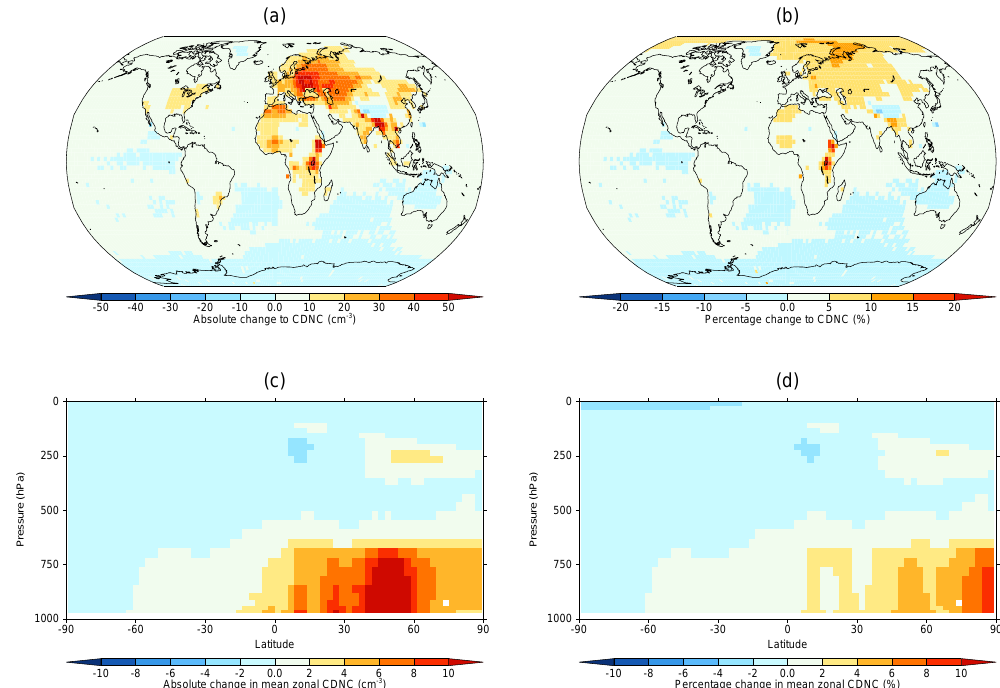
Figure 13. Simulated absolute and percentage change in annual mean at low cloud height (850–900hPa) (a–b) and zonal (c–d) CDNC due to residential emissions (res_base), relative to an equivalent simulation where residential emissions have been removed (res_base_off).